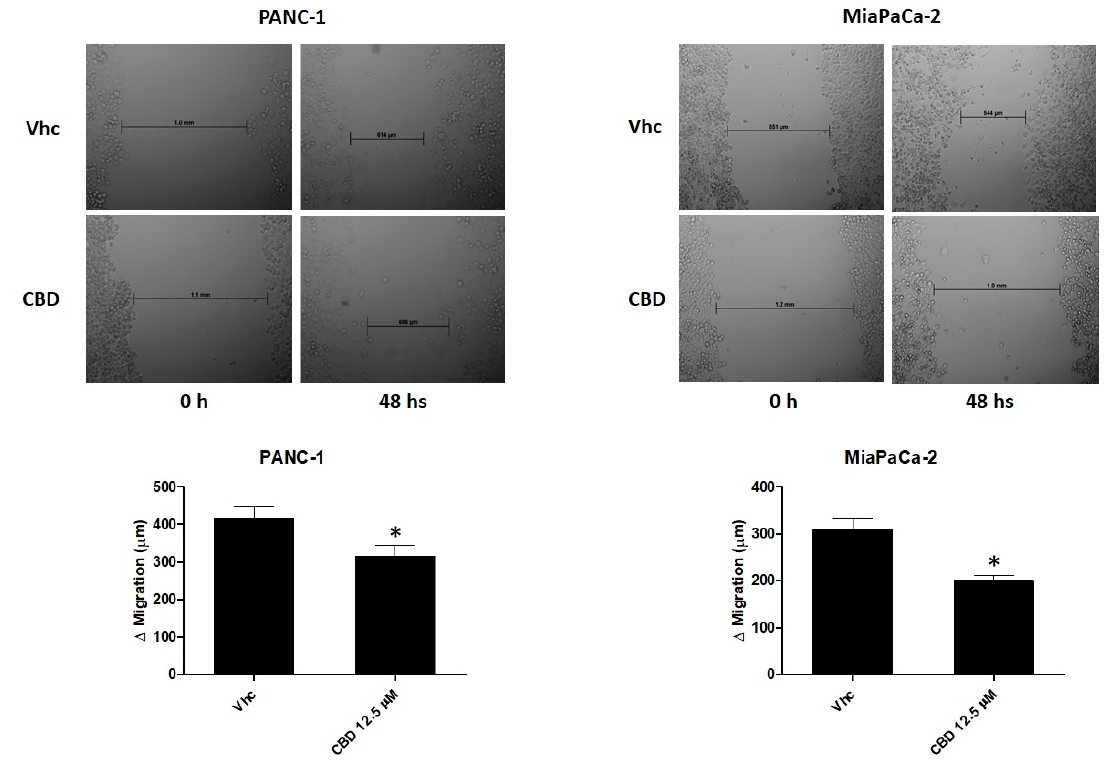
Figure 4. CBD treatment inhibits migration of PDAC cells. Representative image of wound-healing assays for PANC-1 and MiaPaCa-2 cells after treatment with CBD 12.5 µ M for up 48 h. All experiments were repeated three times and images were taken at 0 and 48 h (10 × ). Data are presented as the mean ± SE. * p < 0.05 vs. Vhc.